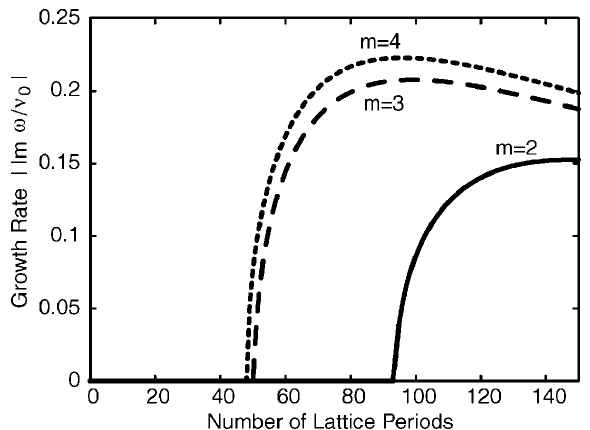
FIG. 7. Growth rate of axisymmetric flute perturbation as a function of transport lattice period for mode numbers m (cid:2) 2 , 3, and 4 during final beam